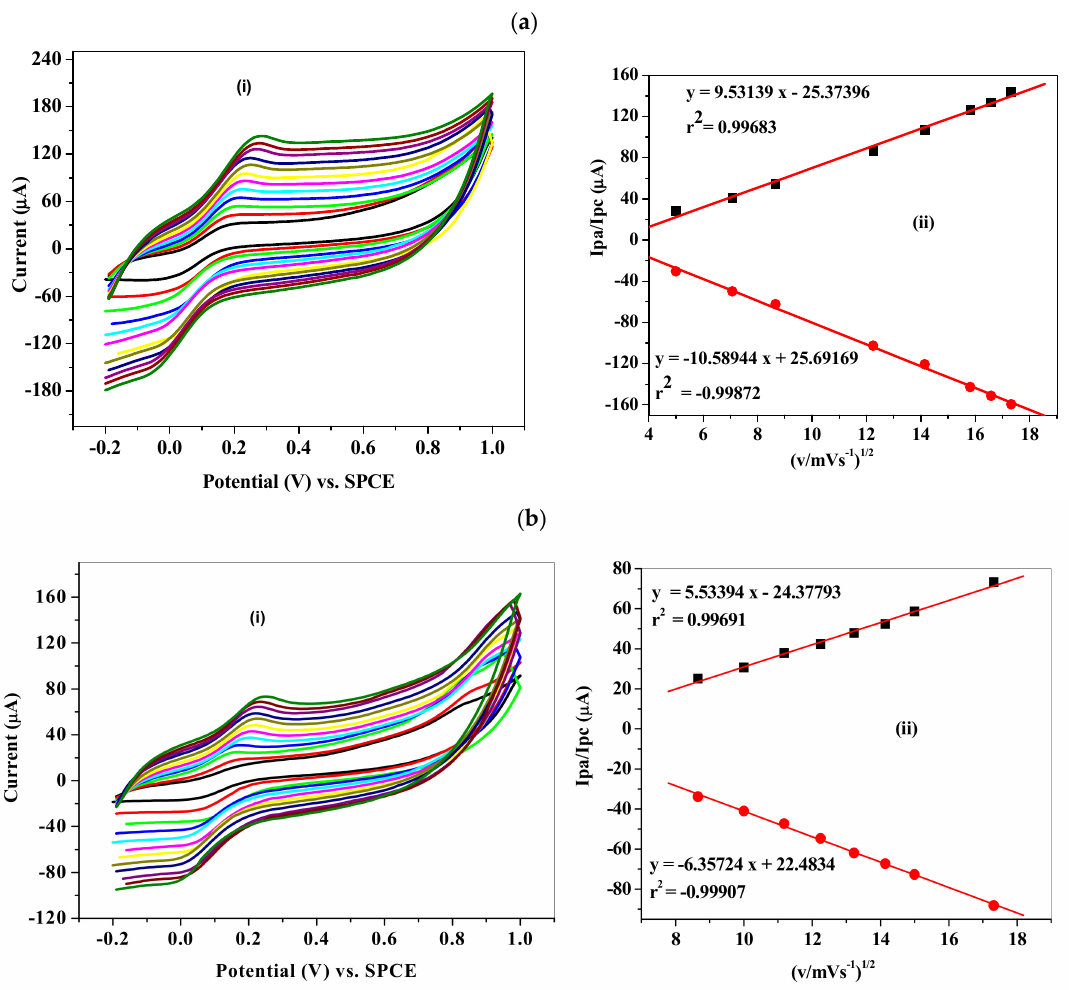
Figure 12. Cyclic voltammogram obtained for ( a ( i )) SPCE / Fe 3 O 4 -NPL and ( b ( i )) SPCE / Fe 3 O 4 -NPF in PBS pH 7.4 containing 5 mM K 3 Fe(CN) 6 solution (scan rate: 25–300 mVs − 1 ; inner to outer) and linear plots of Ipa / Ipc vs. square root ( a ( ii )) and ( b ( ii )) of scan rate for SPCE-Fe 3 O 4 -NPL and SPCE-Fe 3 O 4 -NPF,